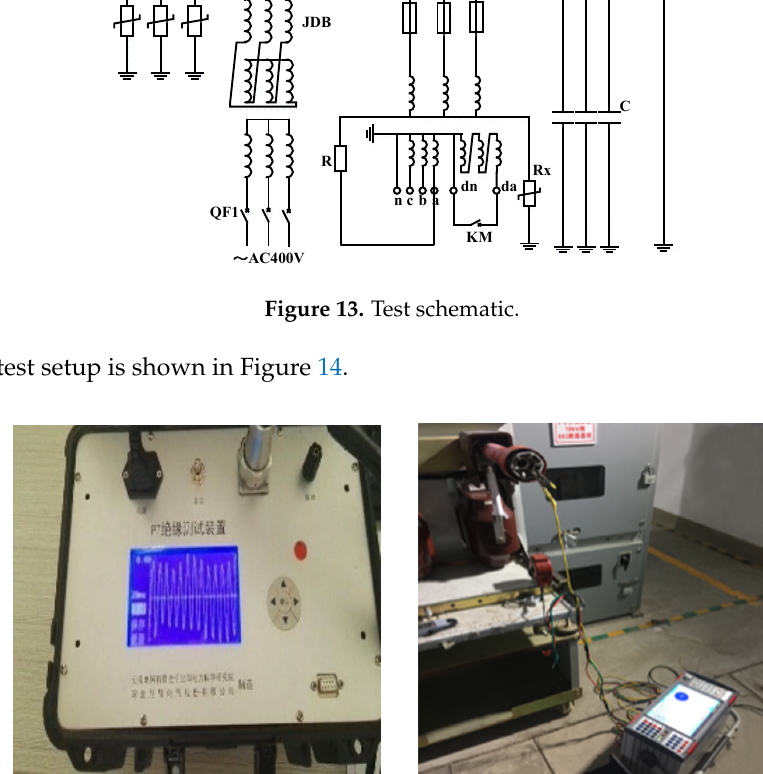
Figure 14. Online detection device test.